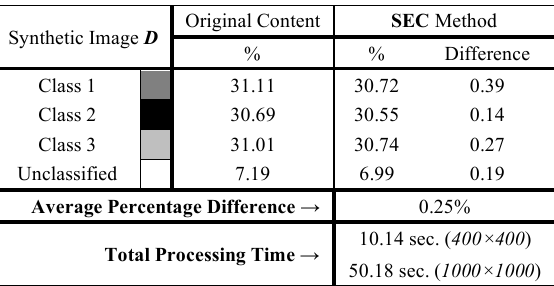
Table 5. Comparative table of the class percentages obtained by the SEC method for the synthetic image D 4.